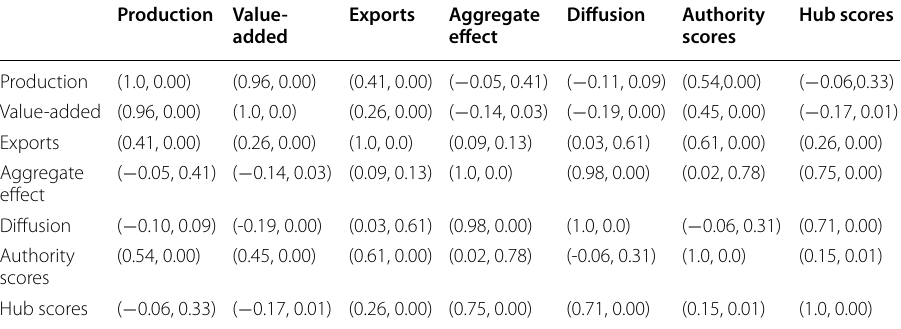
Table 7 Spearman correlation coefficients matrix (rho, p value) 2008. Source: made by authors based on authors calculations using Python 3.8 and Python libraries Production Value- Exports Aggregate Diffusion Authority Hub added effect scores